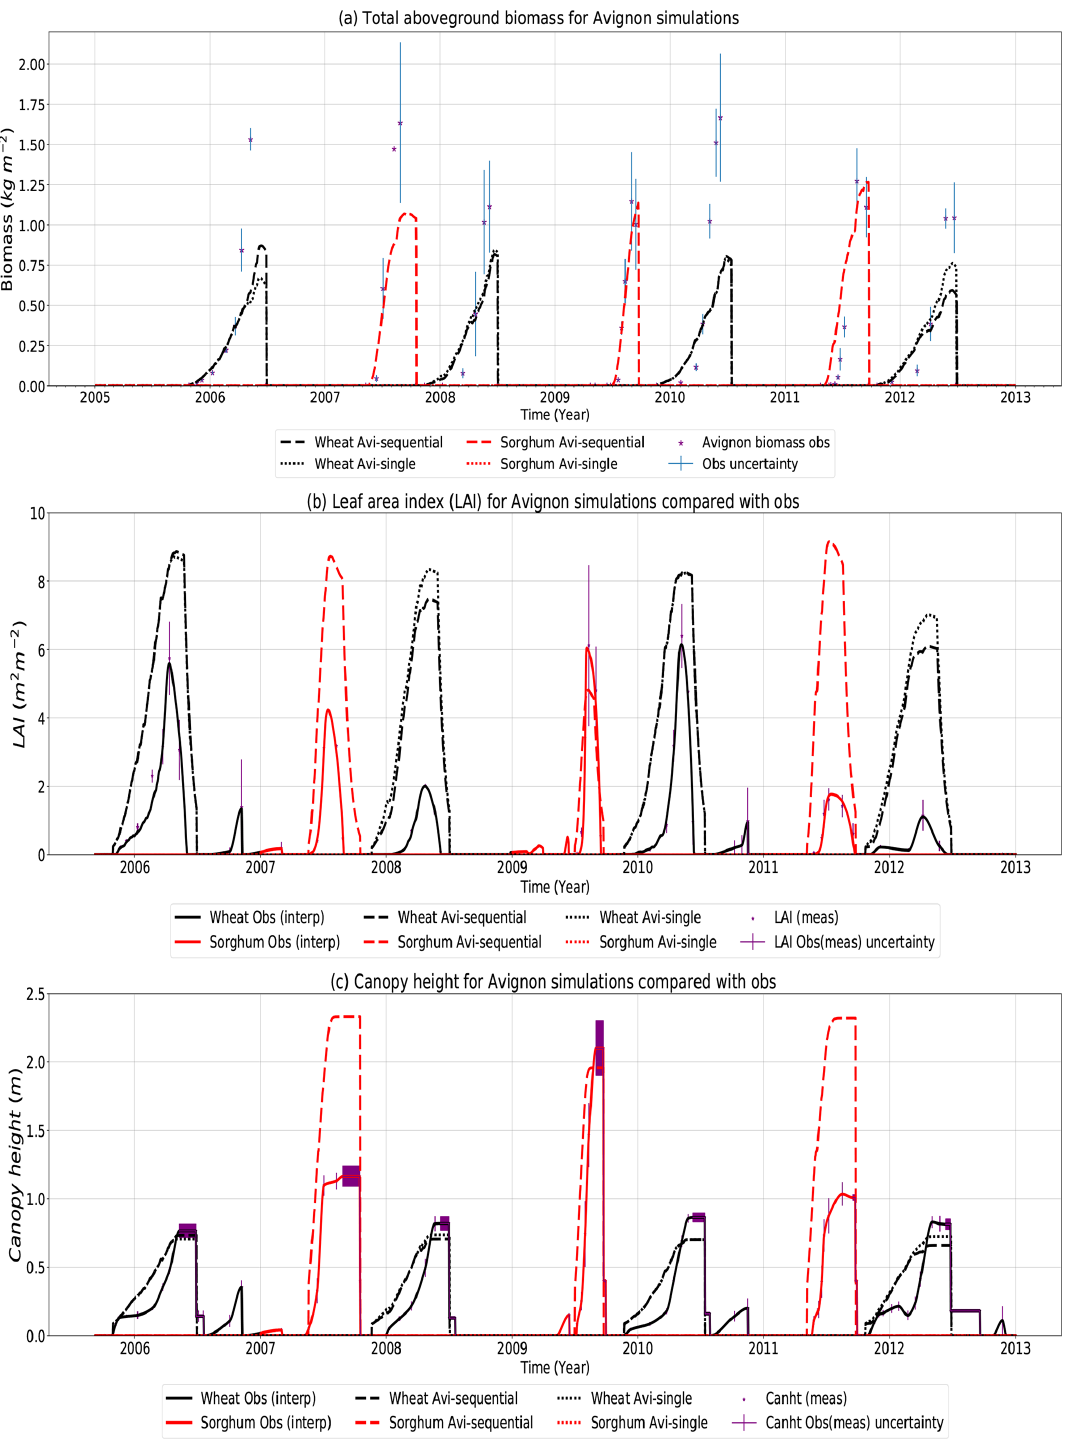
Figure 4. Time series of total aboveground biomass (a) , LAI (b) and canopy height (c) for the Avignon site for wheat (black) and sorghum (red) for observations (solid lines) and simulations using the observed sowing and harvest dates: Avi-sequential (dashed) and the wheat-only Avi-single (dotted) simulations for the period between 2005 and 2013 using observed sowing and harvest dates. Simulations with prescribed LAI and canopy height are not shown here as these follow the observed LAI and canopy height. The dotted red sorghum line in the Avi-single simulation is not visible because this is at zero for the wheat-only simulation. Observed aboveground biomass in panel (a) is shown by purple asterisks. The standard deviation of the measurements is shown to represent the uncertainty in the